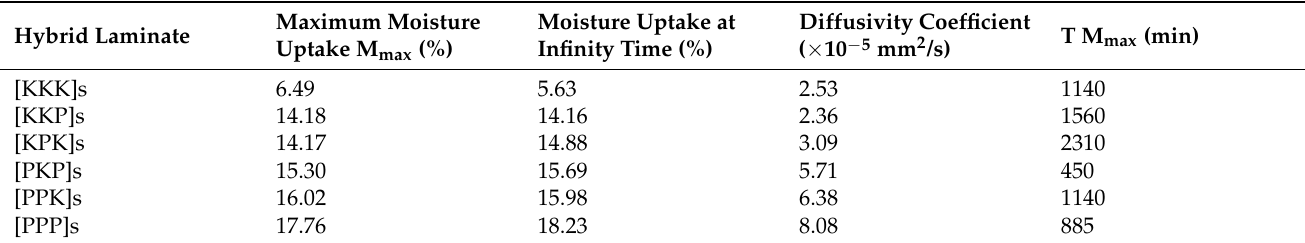
Table 3. Summary of moisture absorption characteristics of PALF/Kevlar-reinforced UP hybrid